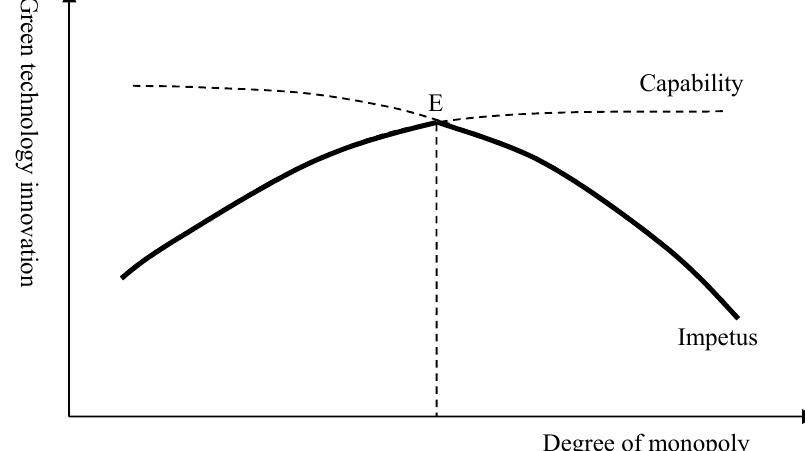
Figure 3. The moderating effect of market structure on green technology innovation.